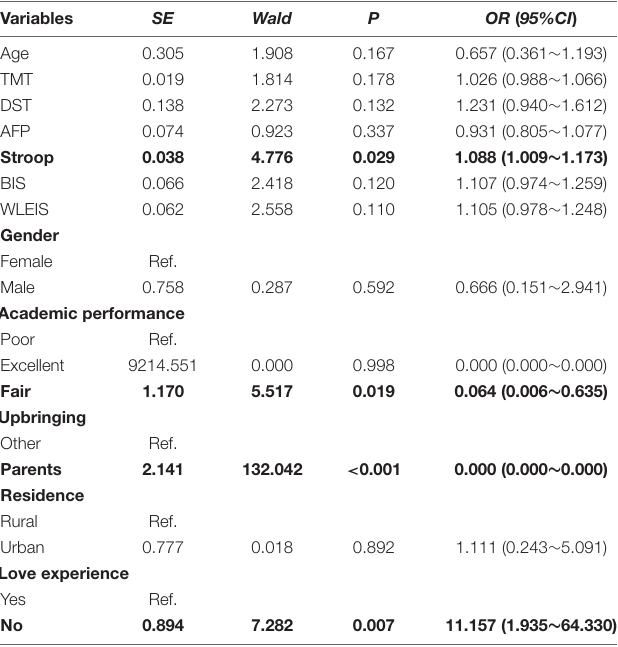
TABLE 3 | Logistic regression of occurring HIGD with